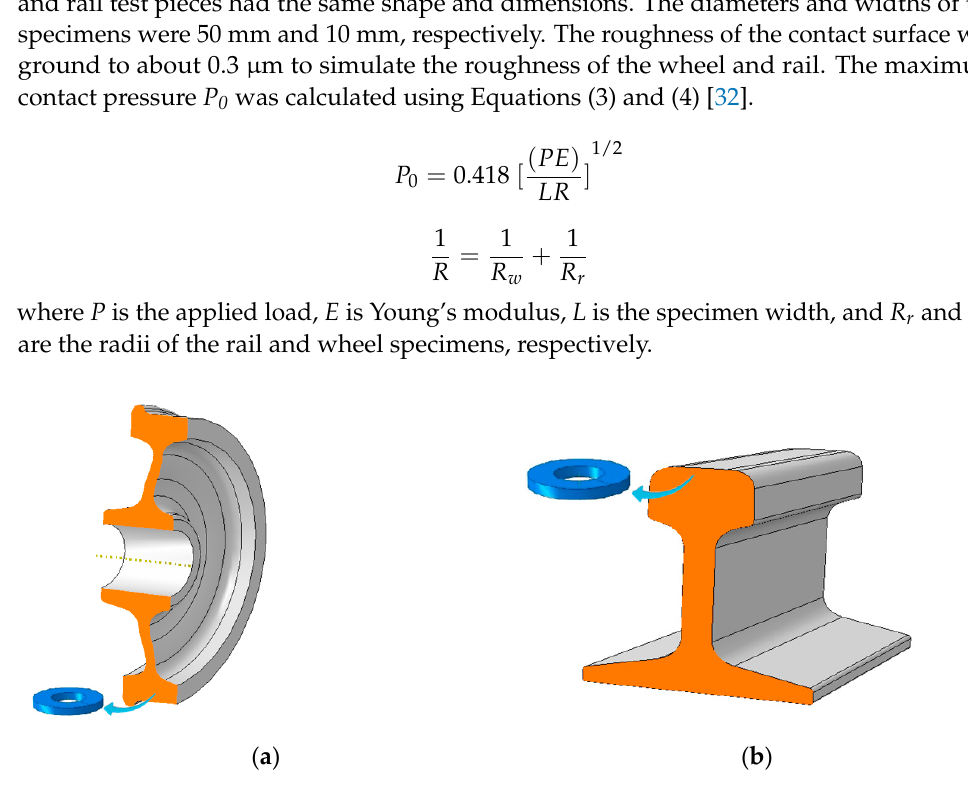
Figure 14. Location and orientation of the test specimen: ( a ) wheel; ( b ) rail.